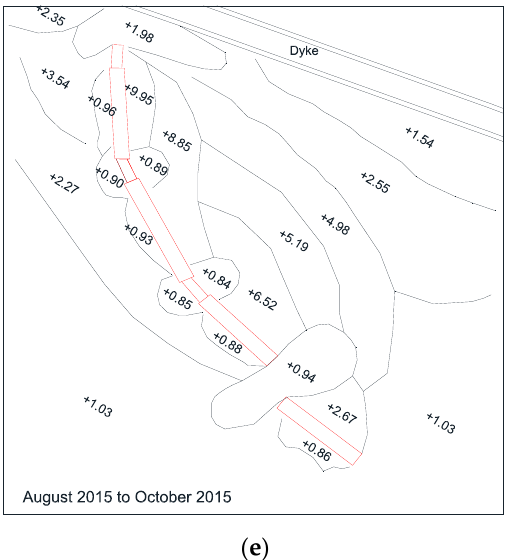
Figure 13. Variation of the sea-bed levels and erosion-deposition pattern in the locality of the breakwater structure over two-month periods from December 2014 to October 2015. Notes: + represents the deposition in cm, ( a , b ) NE season, ( c, d, e ) SW season.